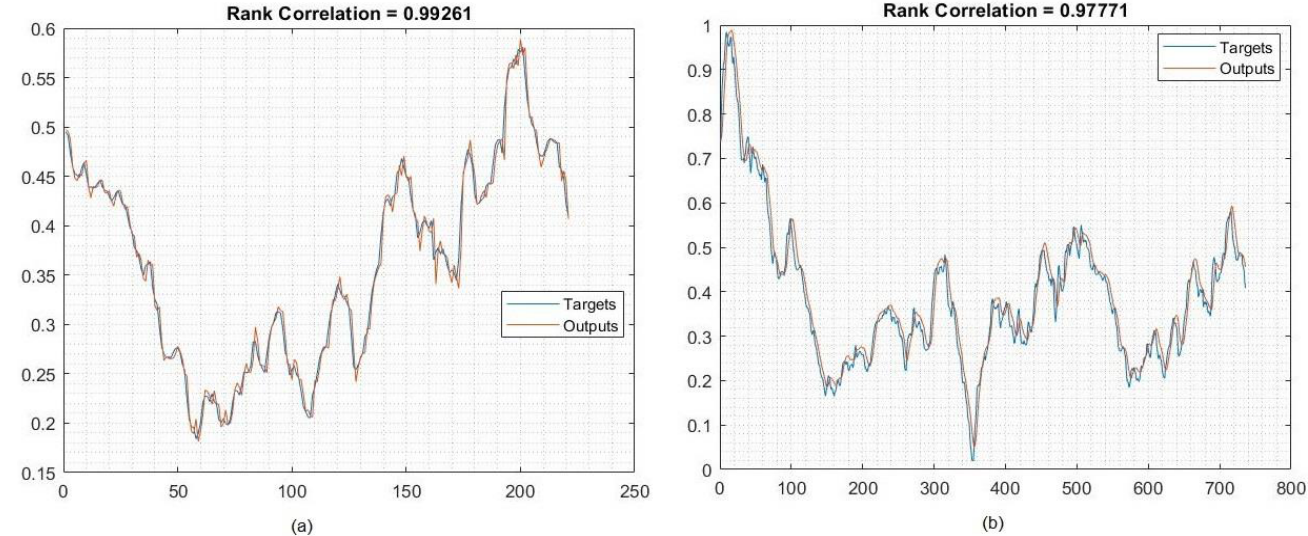
Figure 8. Rank correlation of deep learning models ( a ) CNN-LSTM and ( b ) LSTM for predicting the Tesla stock market closing price during the testing stage.